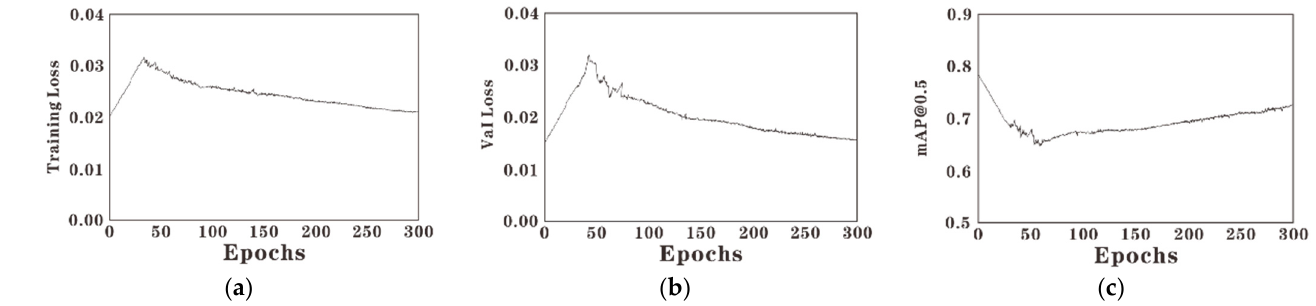
Figure 9. The graph of sparse training process. ( a ) is the training loss curve; ( b ) is the verified loss curve; ( c ) is the mAP curve.